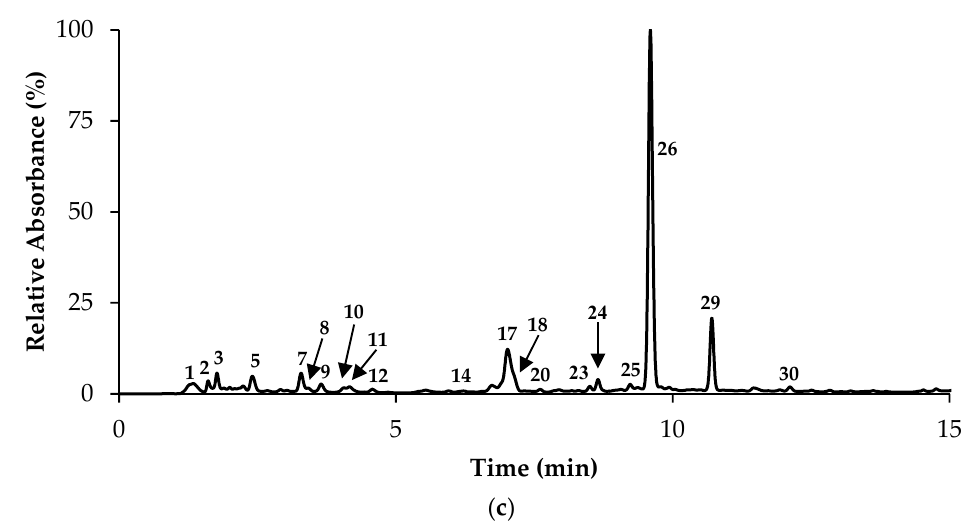
Figure 2. Chromatographic representation of T. zygis ( a ), T. pulegioides ( b ), and T. fragrantissimus ( c ) aqueous extracts at 280 nm. Numbers in the figure correspond to the UHPLC-DAD-ESI-MS n peaks described in Table